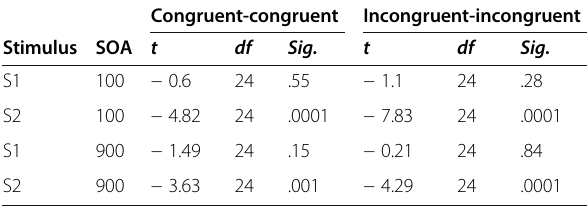
Table 1 The result of mixed-ANOVA tests between the sham and experimental groups in the pre-test